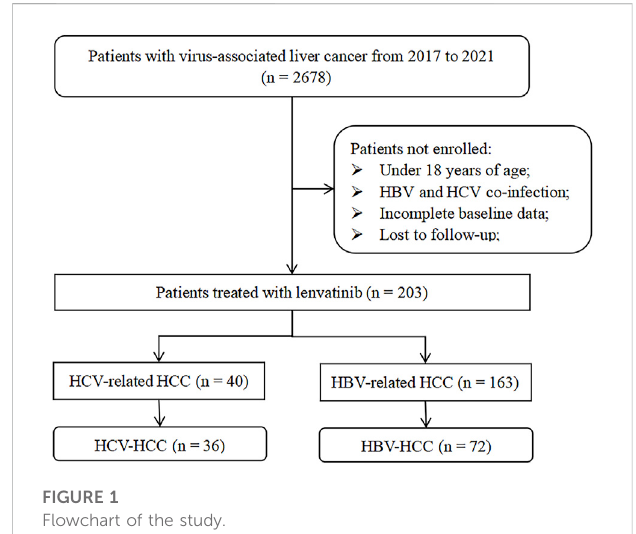
FIGURE 1 Flowchart of the